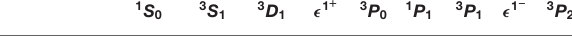
TABLE 3 | The same as in Table 2 but for the scattering phase shifts ( 2 s + 1 L J ) and mixing angles ( ǫ J π ) at E p = 2.25 MeV, both presented in degrees. 1 S